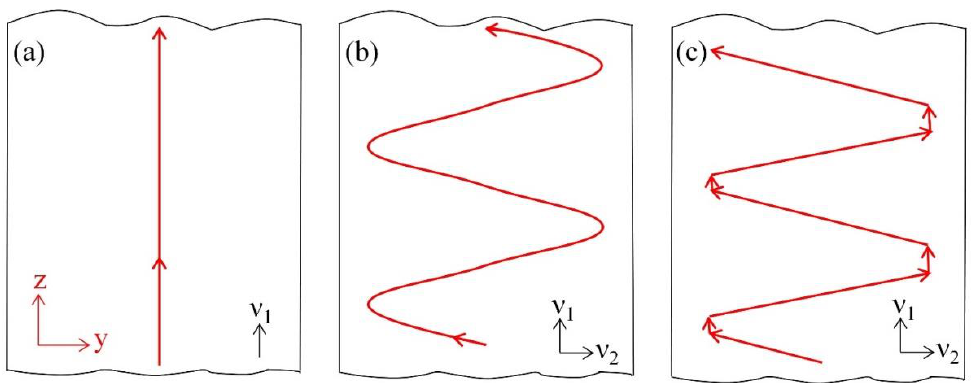
Figure 5. Schematic diagram of heat source (semi-ellipsoid heat source).